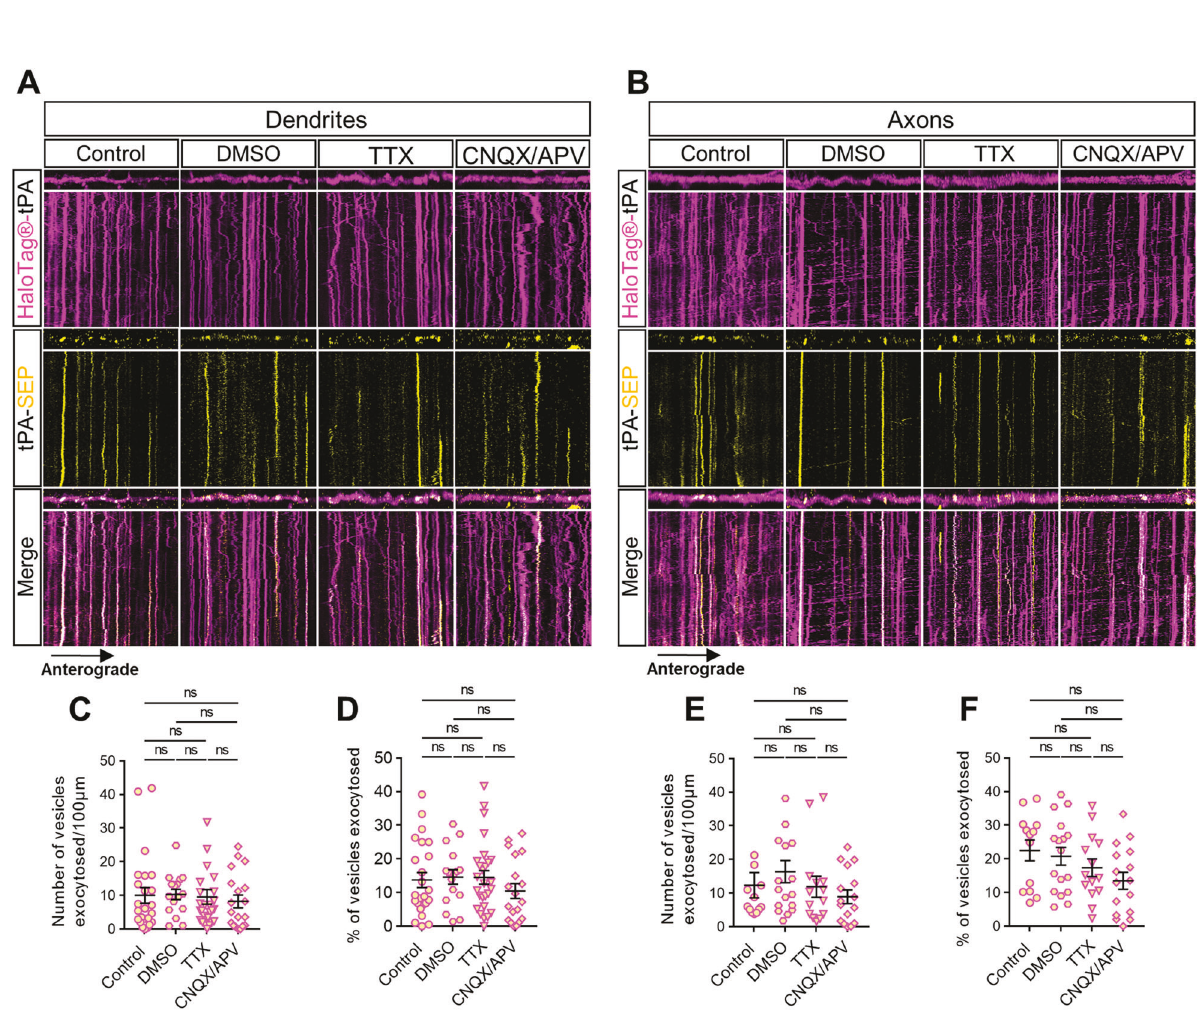
Fig. 4 Neuronal inhibition reveals a constitutive exocytosis of tPA. A , B Representative stacks of time lapse acquisitions on neuronal processes and their associated kymographs displaying HaloTag ® -tPA-SEP during neuronal inhibition with TTX (1.5 µM) and CNQX/APV (50 mM/50 mM) in dendrites (A) and in axons (B). All processes shown in A and B measure 40 µm, and all kymographs represent 40 µm horizontally and 10 min vertically. C Number of vesicles exocytosed per 100 µm in dendrites. Control n = 24, DMSO n = 16, TTX n = 27, CNQX/ APV n = 19 neurons. D Number of vesicles exocytosed (SEP positive) as ratio of the total pool of tPA vesicles (TMR-HaloTag ® positive) on dendrites. Control n = 24, DMSO n = 16, TTX n = 27, CNQX/APV n = 19 neurons ( C , D ) from 2 to 6 independent cultures. E Number of vesicles exocytosed per 100 µm in axons. Control n = 13, DMSO n = 17, TTX n = 14, CNQX/APV n = 16 neurons. F Number of vesicles exocytosed (SEP positive) as the ratio of the total pool of tPA vesicles (TMR-HaloTag ® positives) on axons. Control n = 13, DMSO n = 17, TTX n = 14, CNQX/APV n = 16 neurons ( E , F ) from 2 to 4 independent cultures. C , D , E , F Kruskal – Wallis ’ s test followed by a Dunn ’ s multiple comparisons test were used. Error bars = SEM. A , B kymographs scale: x = 40 µm, y = 10 min. * p < 0.05; ** p < 0.01; *** p < 0.005; **** p < 0.0001, ns not signi fi cant.